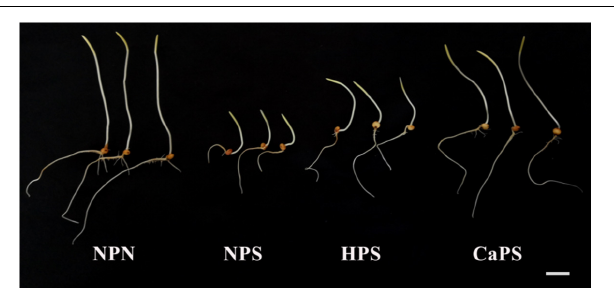
FIGURE 1 | Effect of CaCl 2 priming on sorghum germination phenotype under salt stress.